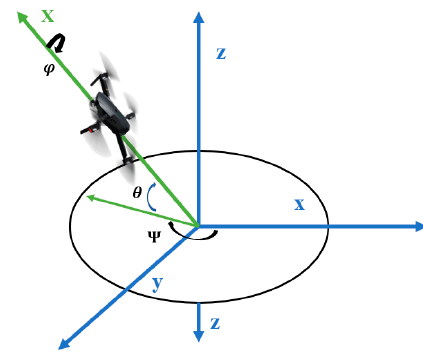
Figure 2. Navigation angles ( Φ , θ , ψ ) defined by Tait-Bryan. Yaw , pitch and roll angles for an aircraft. The fixed frame x , y , z has been moved backwards from center of gravity (preserving angles) for clarity.